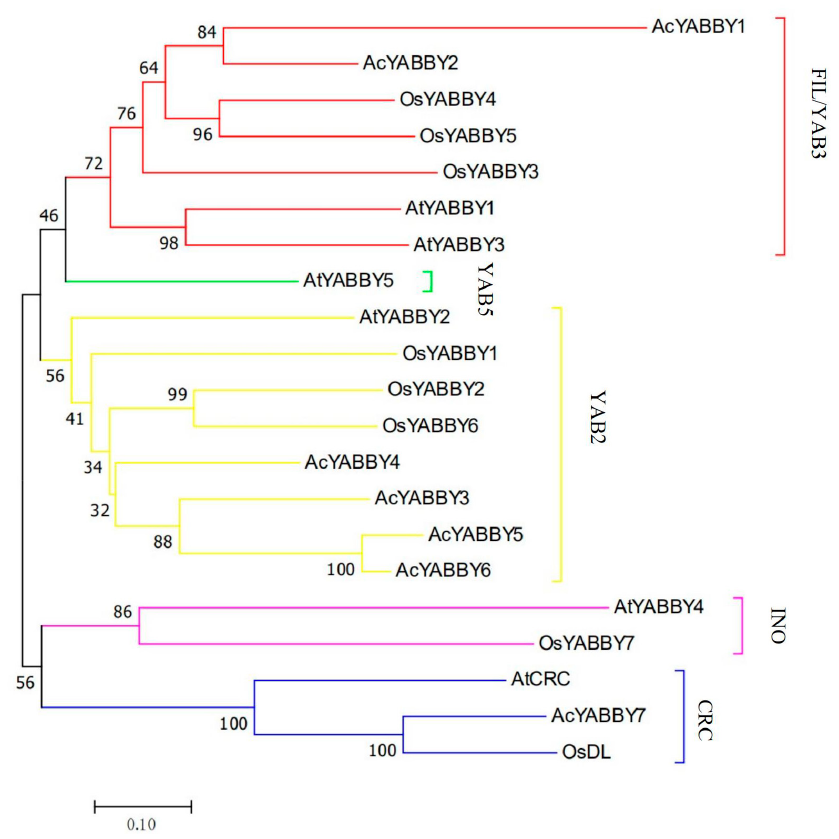
Figure 2. Phylogenetic relationship of the YABBYs proteins of Ac (Pineapple), At ( Arabidopsis thaliana ), Os (Oryza sativa). The phylogenetic tree was made using neighbor-joining with a bootstrap values of 1000. Phylogenetic tree divides YABBYs into five subfamilies ( YAB2 , CRC , YAB5 , FIL / YAB3 and INO ). Each subfamily is represented with different color.